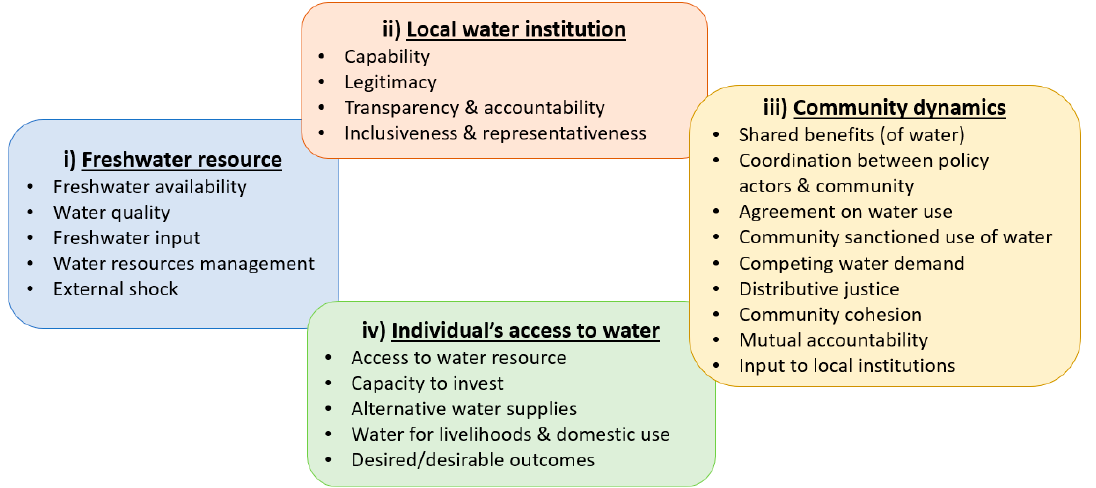
Figure 3. The concepts identified for the local water management framework, grouped according to those related to (i) the physical aspects of the freshwater resource, (ii) the governance of the local water institution, (iii) the community dynamics, and (iv) the individual actor’s access to water.